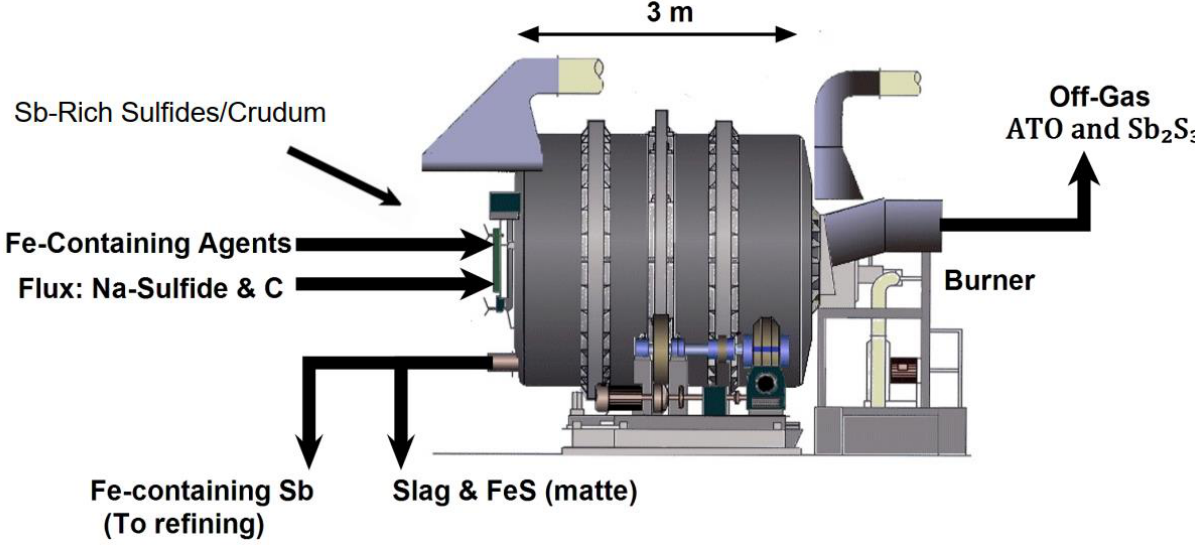
Figure 10. Schematic iron-precipitation process for recovery of antimony (adapted from [2]).